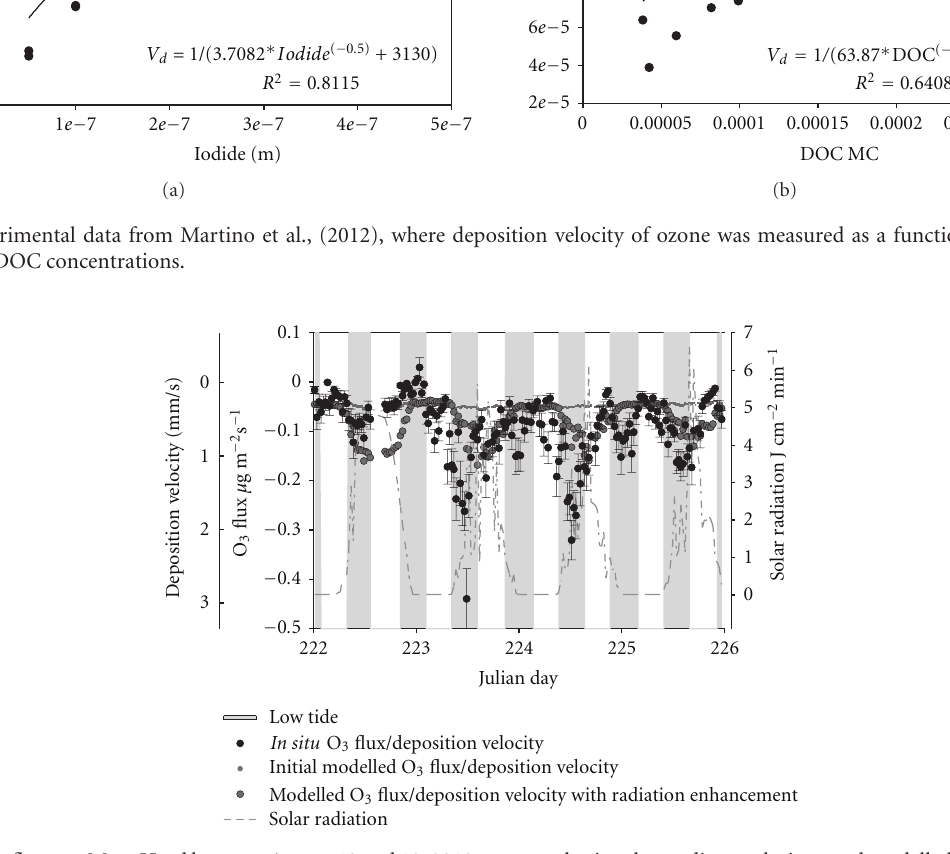
Figure 3: Ozone fluxes at Mace Head between August 10 and 13, 2010, measured using the gradient technique and modelled using deposition scheme of Fairall et al.